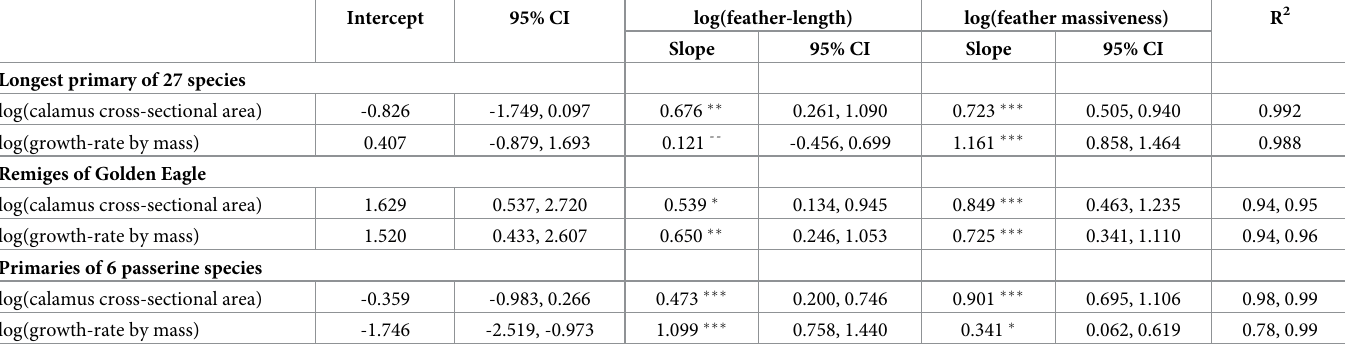
Table 2. Dependence of the cross-sectional area of the calamus, or alternatively growth rate by mass, on both feather-length and feather massiveness (mass of feather material per mm